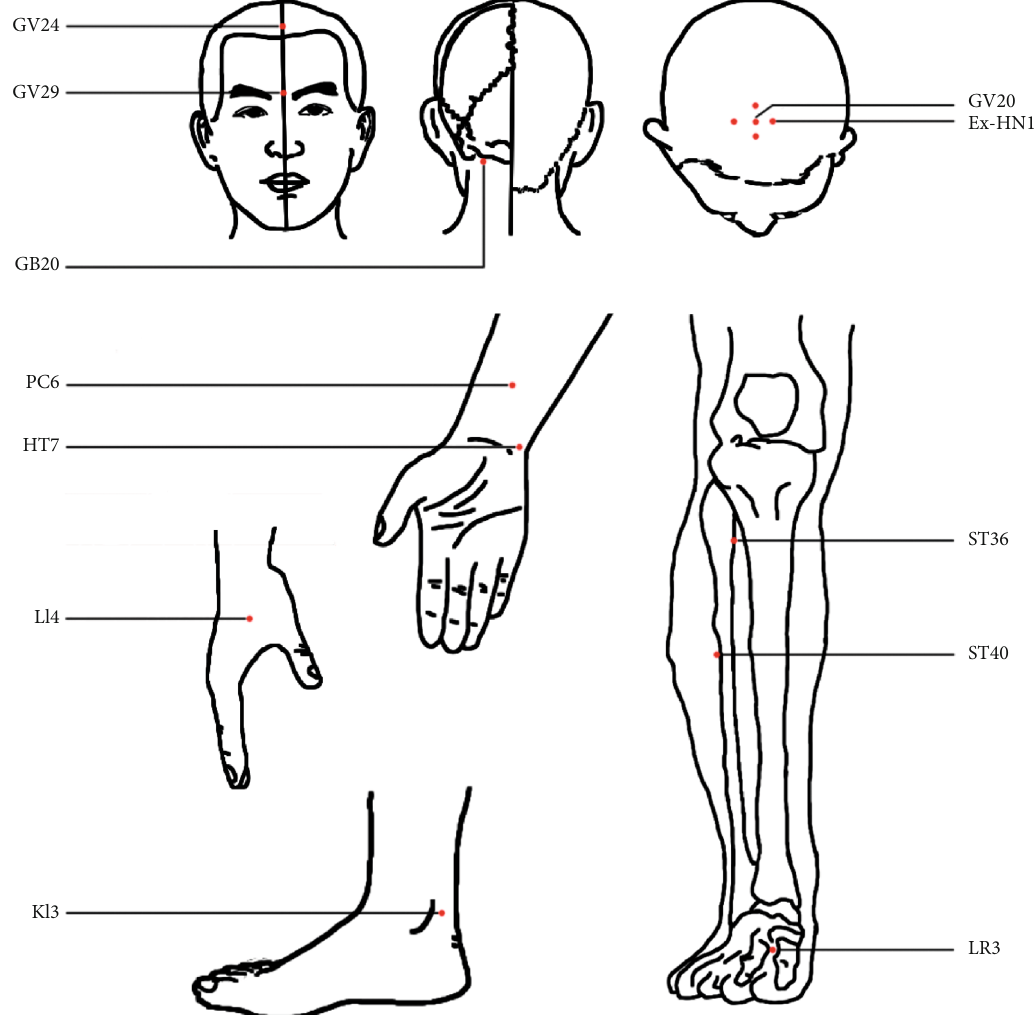
Figure 2: The locations of acupoints in